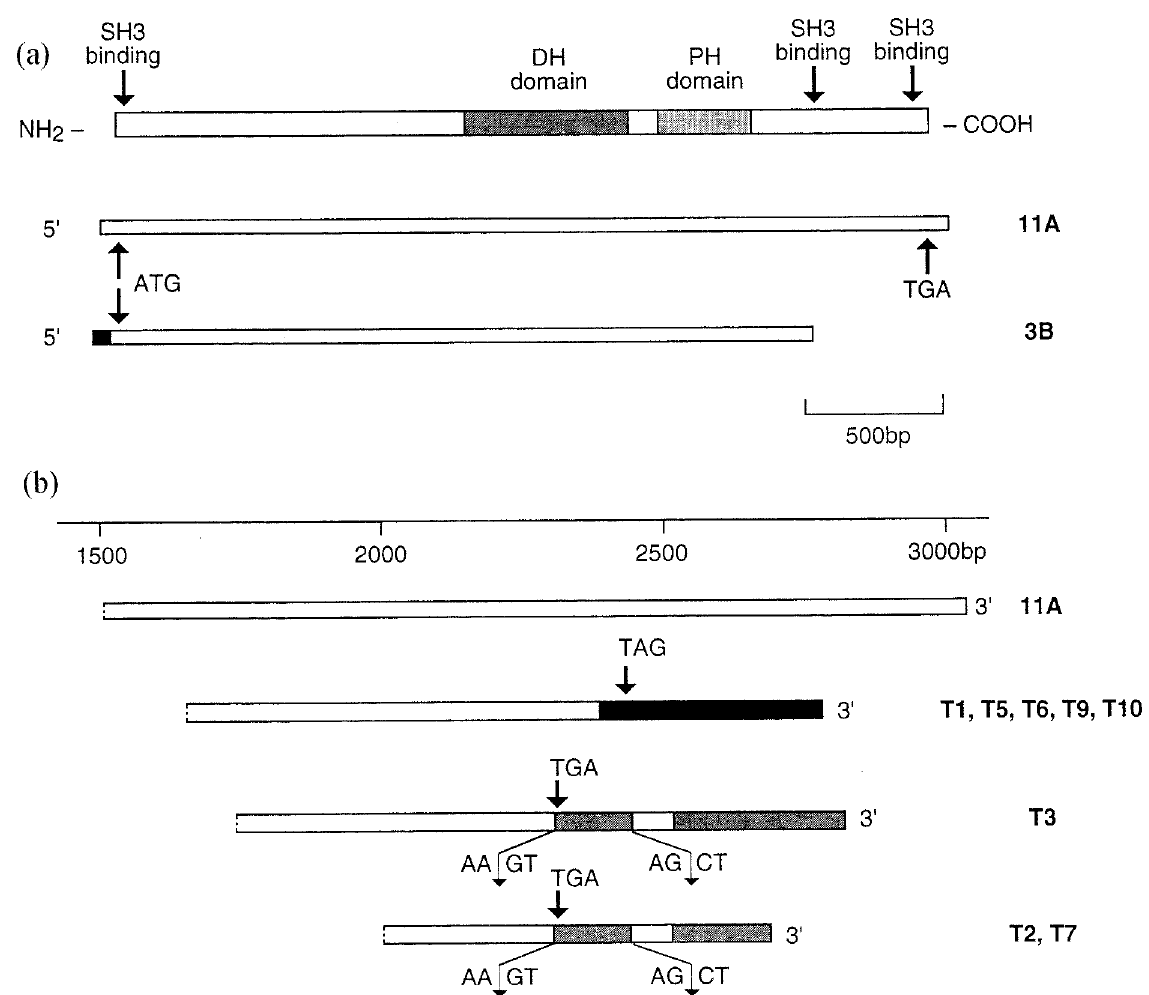
Fig. 1. (a) Schematic representation of the predicted lip protein, the cDNA clones 11A and 3B. The Kozak methionine codon, ATG, present in both clones is marked, as is the in and frame stop codon. The alternative 5 9 sequence in clone 3B is demonstrated. The dbl homology (DH) and pleckstrin homology (PH) domains and the potential SH3 domain-binding sites are also shown. (b) Schematic representation of the 3 9 ends of clone 11A, transfectant clones T1, T5, T6, T9, T10, and T3, T2 and T7. Clones are aligned with respect to clone 11A. The alternative 3 9 sequences in each of the three groups of transfectant clones are demonstrated by shading. The sequence at the junction sites between lip, non-lip sequences in transfectant clones T2, T3, T7 is shown and indicates that the 138-bp sequence inserted between lip nucleotides 2300 and 2301 may be a retained